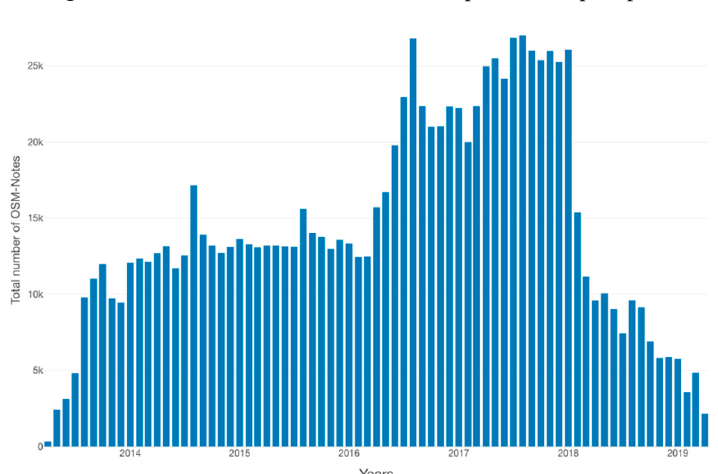
Figure 7. Time transitions of OSM Notes open (first input) post.